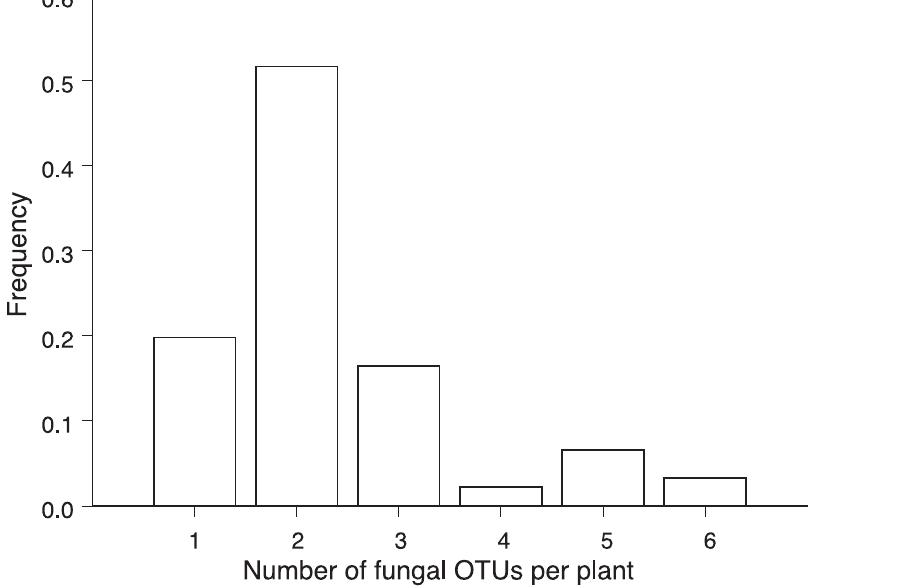
Figure 4. Frequency distribution of the number of fungal operational taxonomic units (OTUs) per individual plant across five Dactylorhiza species sampled in Belgium.